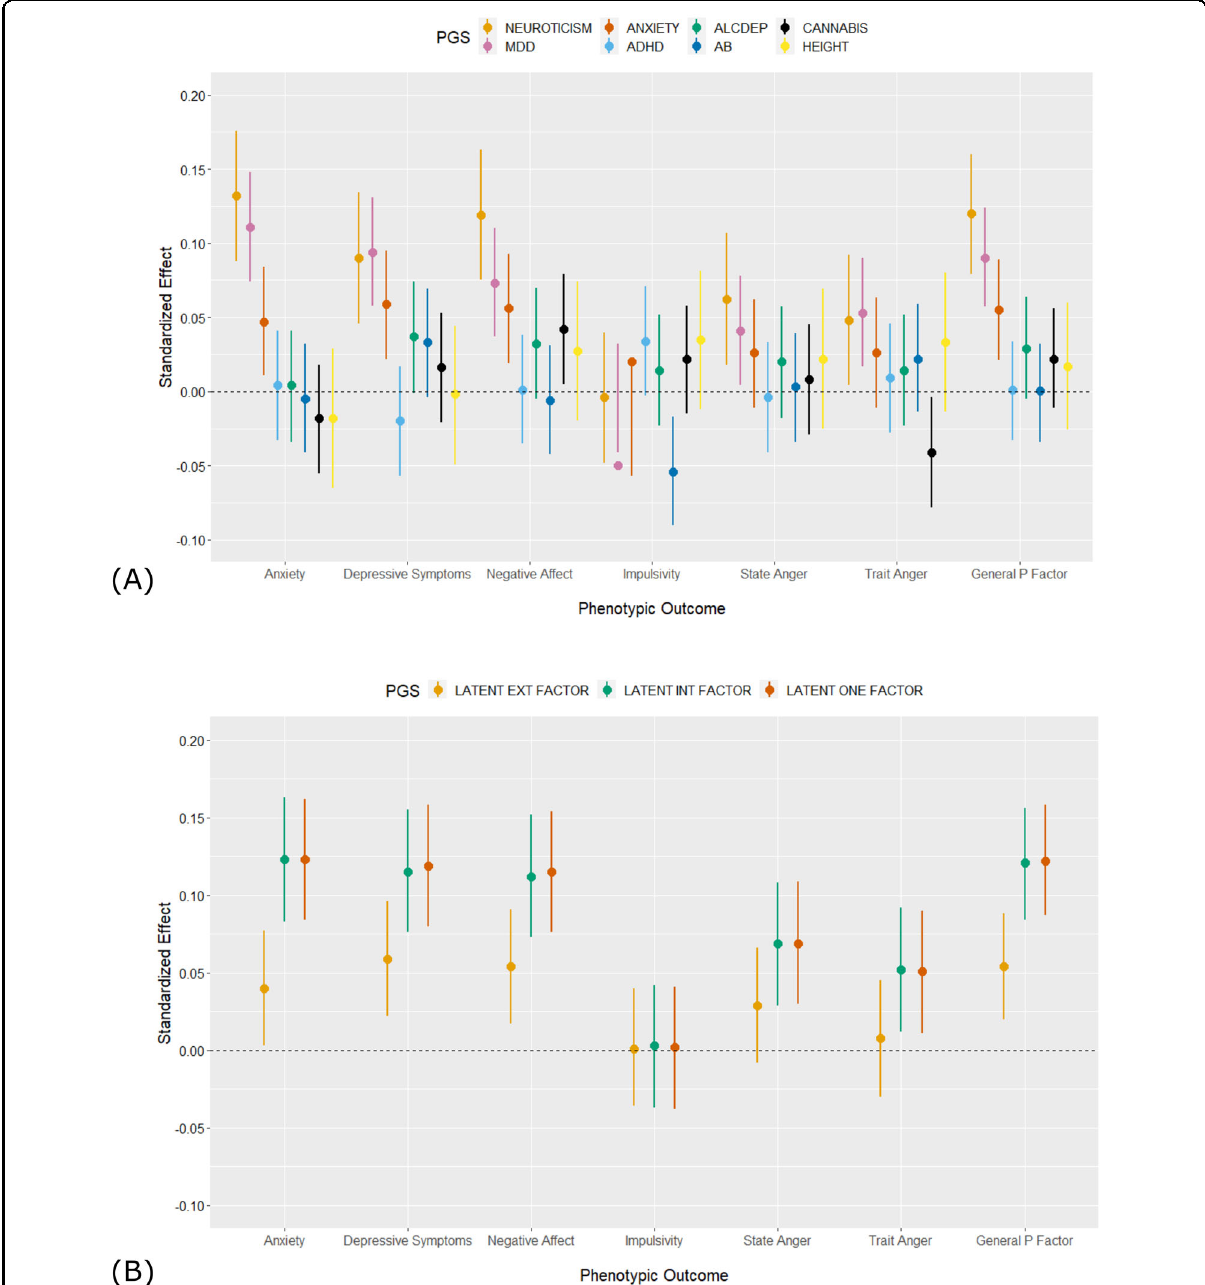
Fig. 3 Polygenic scores for internalizing, but not externalizing, disorders are associated with internalizing and externalizing behaviors in the Health and Retirement Study. N = 3001. Associations between polygenic scores (PGS) and phenotypic outcomes, accounting for the top 10 ancestry principal components. Estimates are unstandardized and error bars are standard errors. A Individual PGSs as predictors; B Latent PGSs, where SNP weights were estimated using Genomic SEM. In both panels, error bars are standard errors around the